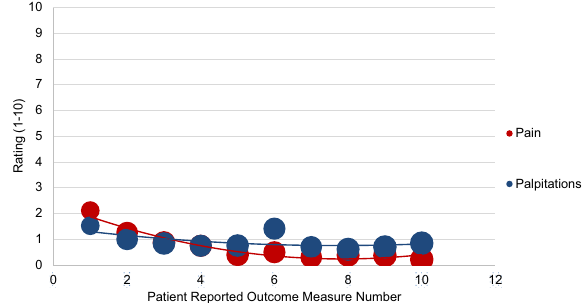
Fig. 8 Responses to post-procedure recovery patient-reported outcome measure questionnaires about pain and palpitations among patients undergoing atrial fi brillation ablation.